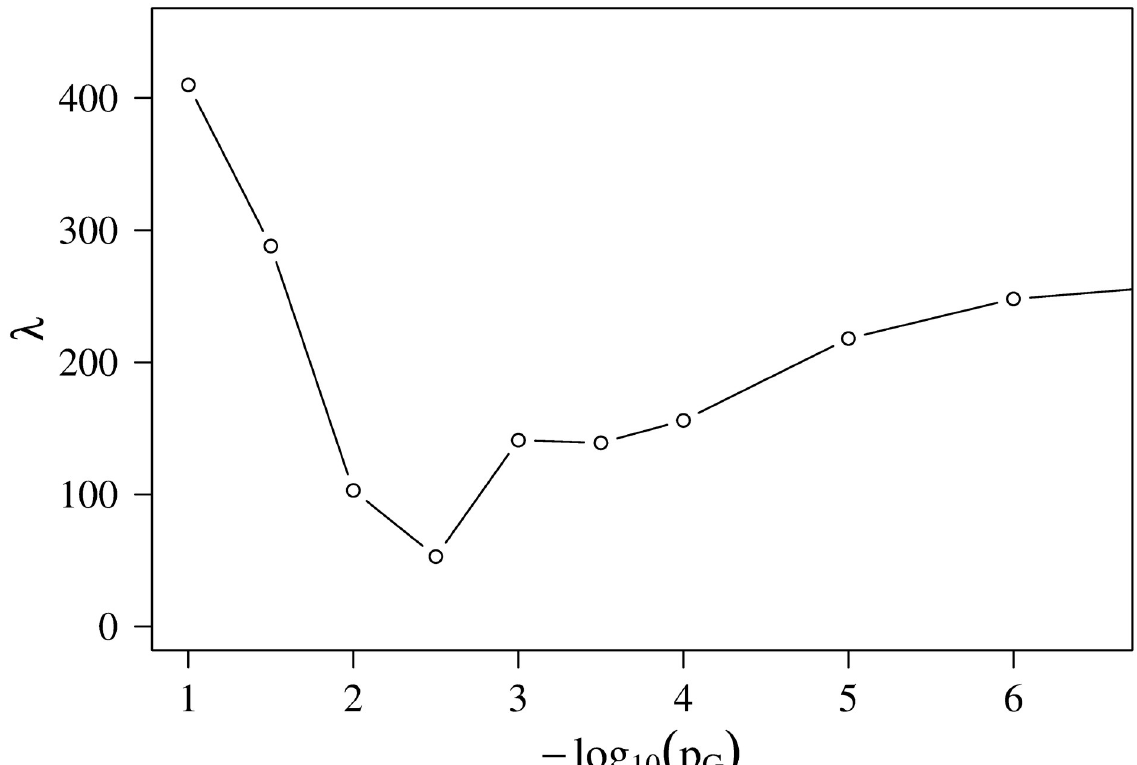
Fig 9. Global penalty without cutoff of reads. Global penalty λ ( M cut = 1 , p